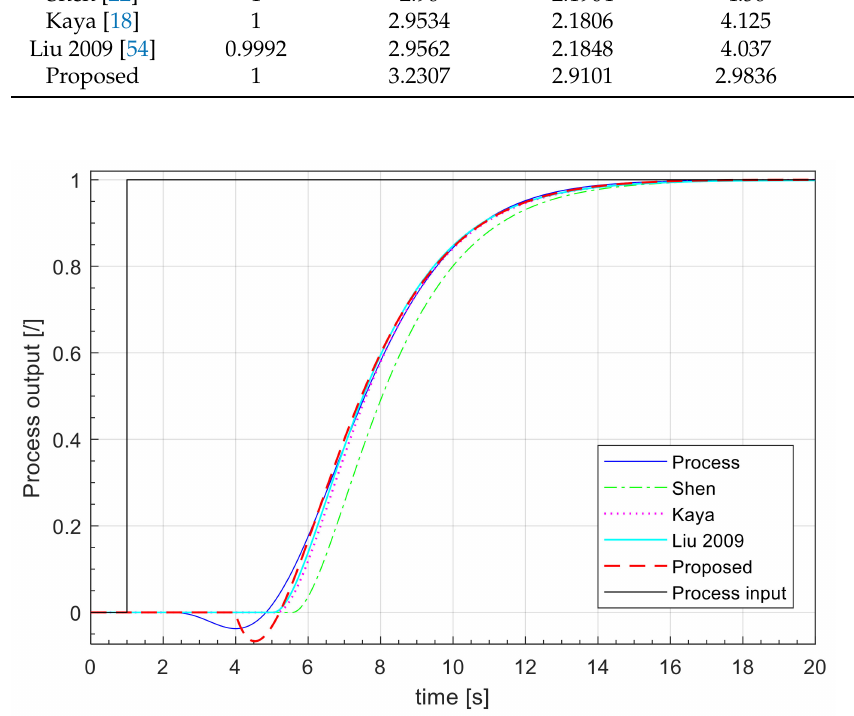
Figure 22. The step-change responses for process G P6 .